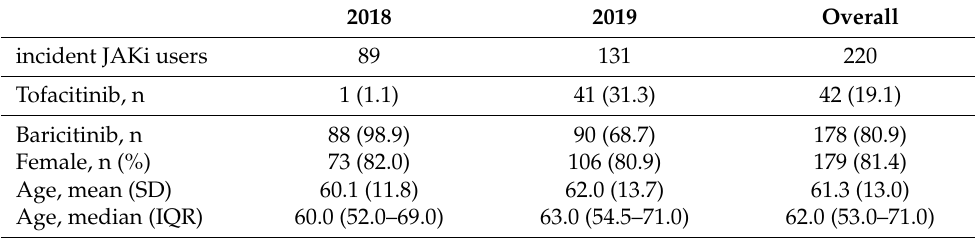
Table 5. JAKi users’ characteristics: overall and stratified for the years of cohort entry (second analysis).